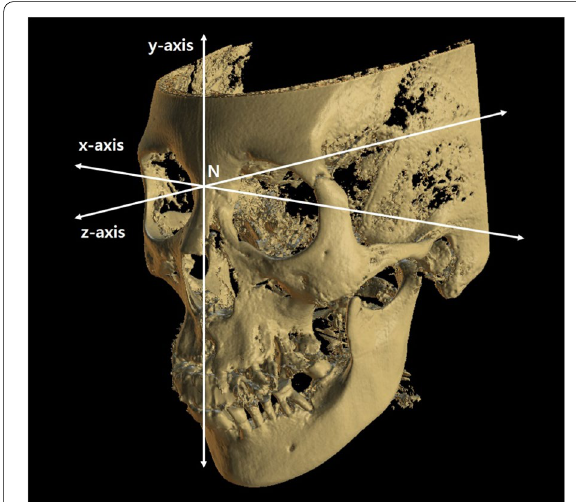
Fig. 2 Three‑dimensional coordinate system. The Frankfort horizontal plane is the reference plane, and the nasion is the center of all axes. The medial‑lateral movement was evaluated by the x‑axis. The vertical movement was evaluated by the y‑axis. The anterior‑posterior movement was evaluated by the